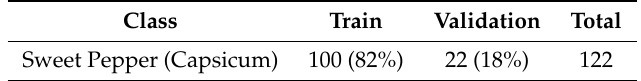
Table 5. Distribution of training and testing images used in DeepFruit